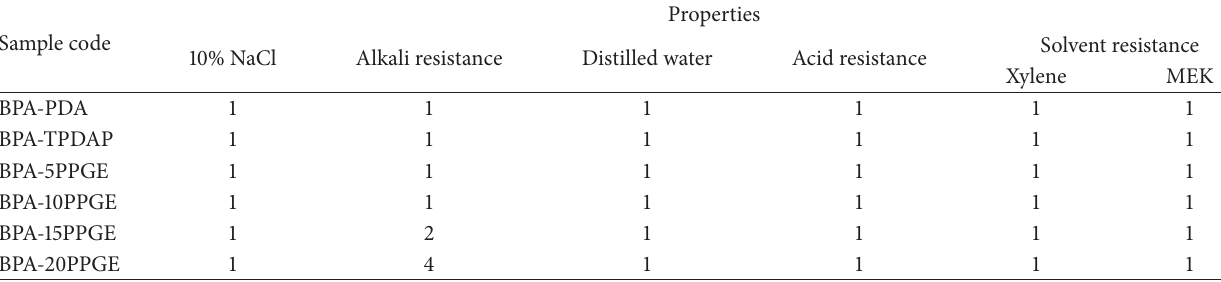
Table 3: Chemical properties of epoxy resin-PPGE coatings.